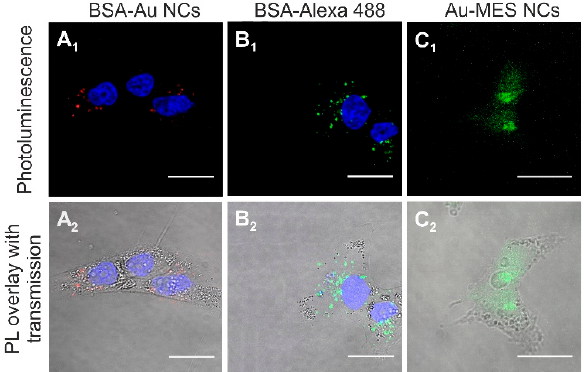
Figure 5. Accumulation of photoluminescent BSA-Au NCs ( λ ex = 488 nm) ( A 1 , A 2 ), BSA-Alexa 488 conjugate ( λ ex = 488 nm); ( B 1 , B 2 ), and photoluminescent Au-MES NCs; ( C 1 , C 2 ) in MDA-MB-231 cells. Cells were incubated with BSA-Au NCs and BSA-Alexa 488 conjugate for 24 h, with Au-MES NCs—for 6 h. In ( A 1 , A 2 , B 1 , B 2 ), nuclei were stained with Hoechst 33258 ( λ ex = 405 nm). Scale bar is 25 μ m.